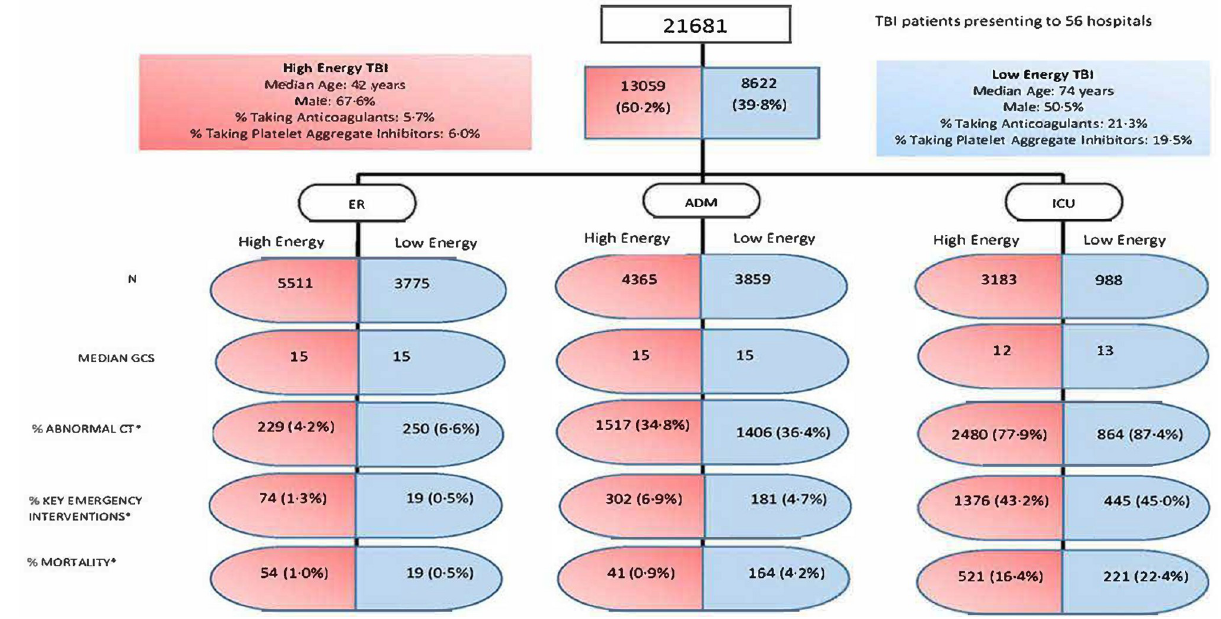
Fig 3. High-energy and low-energy TBI patient characteristics compared within 3 care pathways. The 3 care pathways are as follows: discharged or died in emergency department (ER; left column), admitted to ward but not receiving critical care in study hospital (ADM; central column), and admitted and received critical care in study hospital intensive care unit (ICU; right column). � Denominator is number of patients in energy transfer and care pathway cohort. CT, computed tomography; GCS, Glasgow Coma Score; TBI, traumatic brain injury.